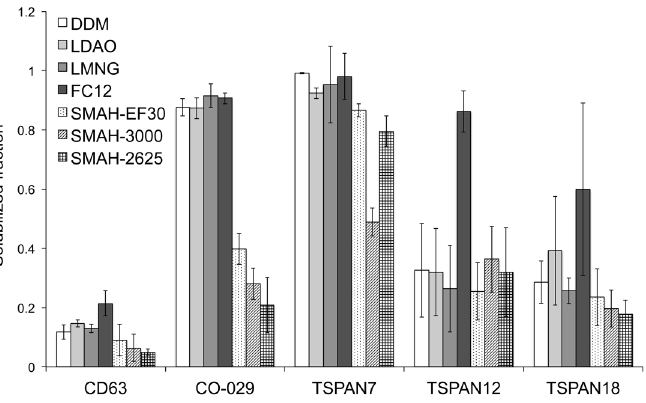
Fig 4. Solubilization efficiency of TSPAN-GFP fusion proteins. The solubilization degree of five tetraspanin-containing yeast membranes with the help of detergents and SMA polymers. The solubilization ratio was determined by comparing the fluorescence counts of solubilized material after ultracentrifugation to the mix before separation of solubilized and non-solubilized